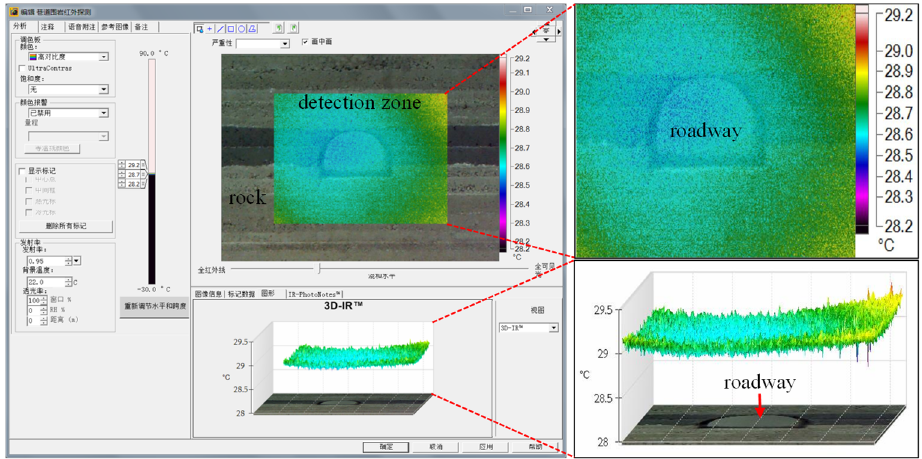
Figure 5. Infrared thermal analysis software. (Its function keys only provide Chinese display).